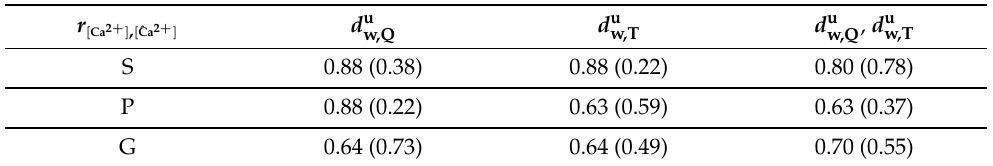
Table 5. Intra-patient Pearson correlation coefficient r between actual and estimated [ Ca 2 + ] using univariable and multivariable estimators, with stage-specific (S), patient-specific (P) and global (G) approaches. Values are expressed as median (IQR).